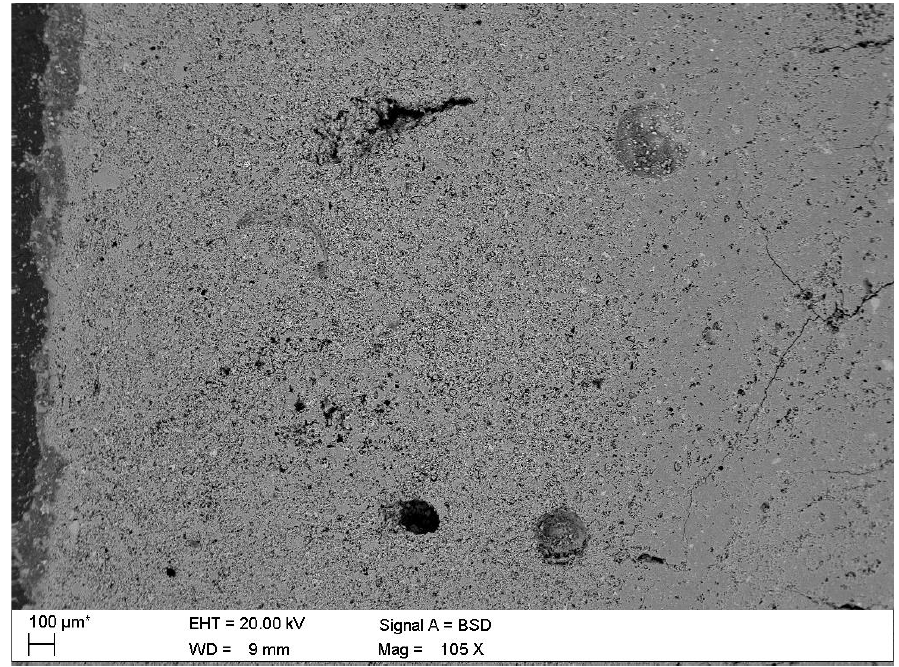
Figure 14. Increased porosity at the edge of sample B-4 to about 2400 μ m and increased density of the specimen on the very surface with a thickness of up to 100 μ m (external edge of the sample is located at the left side of the image).